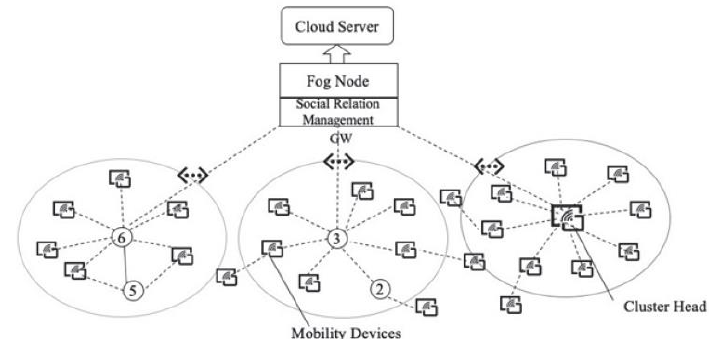
Figure 8. Data Collection Model (see [53]).